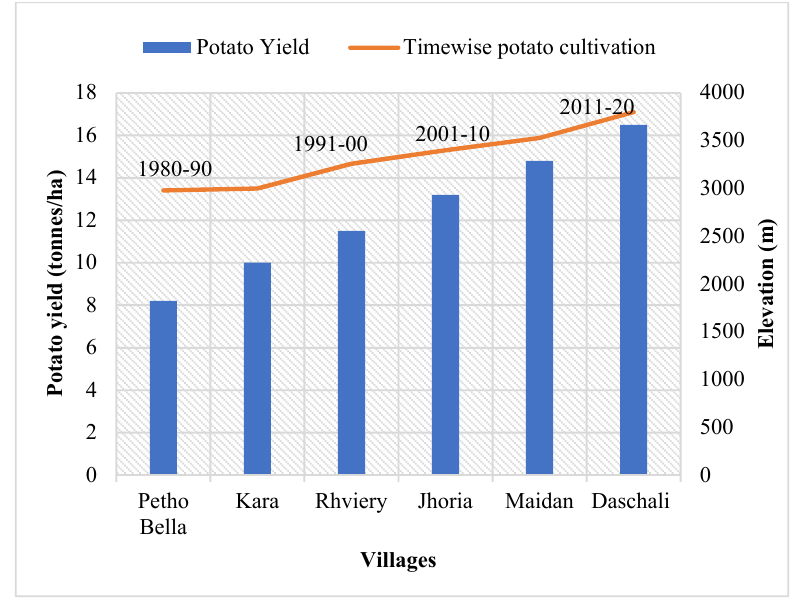
Figure 3. Time- and elevation-wise potato productivity in Buhrawai valley.